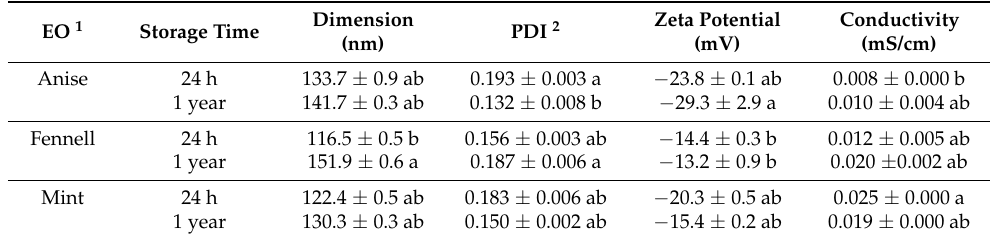
Table 1. Physical characterization of the essential oil-based nano-emulsions. Values are means ( ± standard error) of three replicates. Different letters indicate significant differences among the values of the same parameter within the same column (Dunn’s post hoc test, p < 0.05). Dimension Zeta Potential Conductivity PDI 2 EO 1 Storage Time (nm) (mV) (mS/cm) Anise 24 h 133.7 ± 0.9 ab 0.193 ± 0.003 a − 23.8 ± 0.1 ab 0.008 ± 0.000 b 1 year 141.7 ± 0.3 ab 0.132 ± 0.008 b − 29.3 ± 2.9 a 0.010 ± 0.004 ab Fennell 24 h 116.5 ± 0.5 b 0.156 ± 0.003 ab